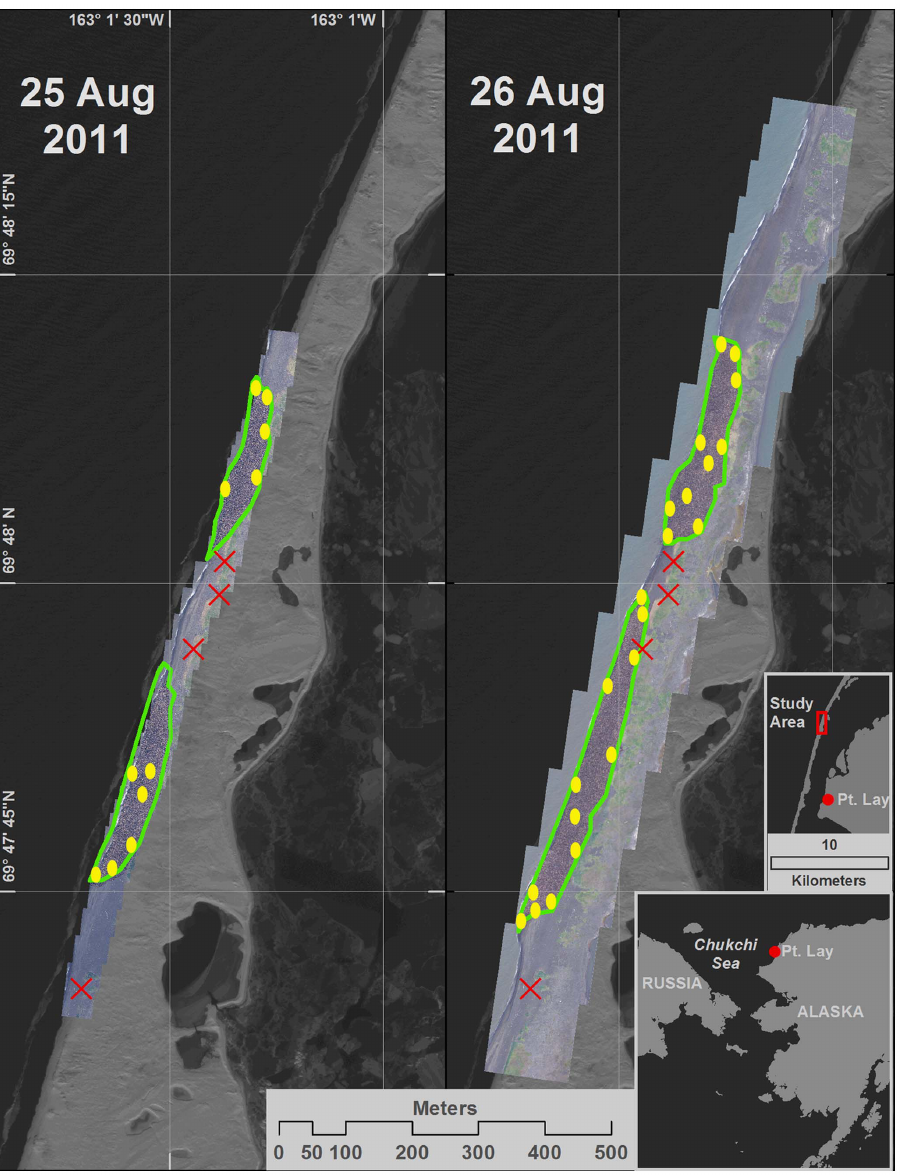
Figure 1. Walrus haulout location near Pt. Lay, Alaska. Equally scaled composite images of two walrus herds hauled out near Pt. Lay on the NW coast of Alaska on August 25 th (left photo) and August 26 th (right photo), 2011. Green lines delineate the outline of the herd and yellow circles identify approximate location of the focal point for hold sequences. Red X’s indicate the north location of paired reference marks used to scale the